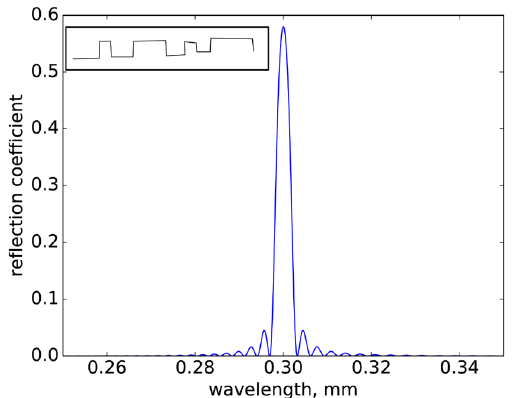
Figure 6. Reflection of a long weak narrow-line probe pulse in dependence on its wavelength from a grating containing 1000 periods ( 75 µ m each) in a medium with 1 bar pressure of the active molecules. The inset shows schematically a CW wave modulated by switching on and off the grating dynamically as a function of time. This figure was created in Phython 2.7, preinstalled with Ubuntu linux 18.04.05 (https ://ubunt